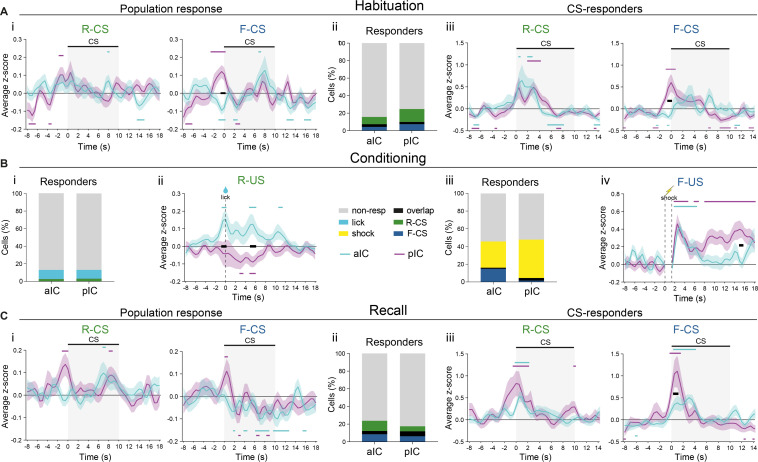
Responses to Pavlovian learning task stimuli in IC.In all panels, black lines indicate significant differences (p<0.05) between subregions, as determined by Holm-Sidak post hoc analyses, while colored lines indicate significant differences (p<0.05) from zero for each subregion, as determined by one-sample t-tests. All data presented as mean ± SEM. (A) (i) PETH of CS-evoked population responses of IC subregions for (left) R-CS (significant effect of time in a two-way RM ANOVA, F52,11180=1.61, p=0.0037) and (right) F-CS (significant time x subregion interaction in a two-way RM ANOVA, F52,11076=2.23, p<0.0001) at habituation. (ii) Percentage of neurons responsive to task stimuli, determined by trial-averaged neuronal responses above a z-score of 1.65 at habituation. (iii) PETH of CS-evoked responses of IC responders (from ii) for (left) R-CS (significant effect of time in a two-way RM ANOVA, F52,1664=5.682, p<0.0001) and (right) F-CS (significant time x subregion interaction in a two-way RM ANOVA, F52,884=1.782, p=0.0007) at habituation. (B) (i) Percentage of neurons responsive to task stimuli, as determined by trial-averaged neuronal responses above a z-score of 1.65 in RC. (ii) Average z-scored population responses of IC subregions as PETH upon R-US (significant time x subregion interaction in a two-way RM ANOVA, F52,14248=1.87, p=0.0002). (iii) Percentage of neurons responsive to task stimuli, as determined by trial-averaged neuronal responses above a z-score of 1.65 in FC. (iv) Average z-scored population responses as PETH of IC subregions upon F-US (significant time x subregion interaction in a two-way RM ANOVA, F50,7100=2.29, p<0.0001). (C) (i) PETH of CS-evoked population responses at recall of IC subregions for (left) R-CS (no significant effect in a two-way RM ANOVA) and (right) F-CS (significant effect of time in a two-way RM ANOVA, F52,14560=2.42, p<0.0001). (ii) Percentage of neurons responsive to task stimuli, determined by trial-averaged neuronal responses above a z-score of 1.65 at recall. (iii) PETH of CS-evoked responses of IC responders (from ii) for (left) R-CS (significant effect of time in a two-way RM ANOVA, F52,1924=2.984, p<0.0001) and (right) F-CS (significant time x subregion interaction in a two-way RM ANOVA, F52,1716=2.159, p<0.0001) at recall. Full statistical report in Appendix 1—table 1.